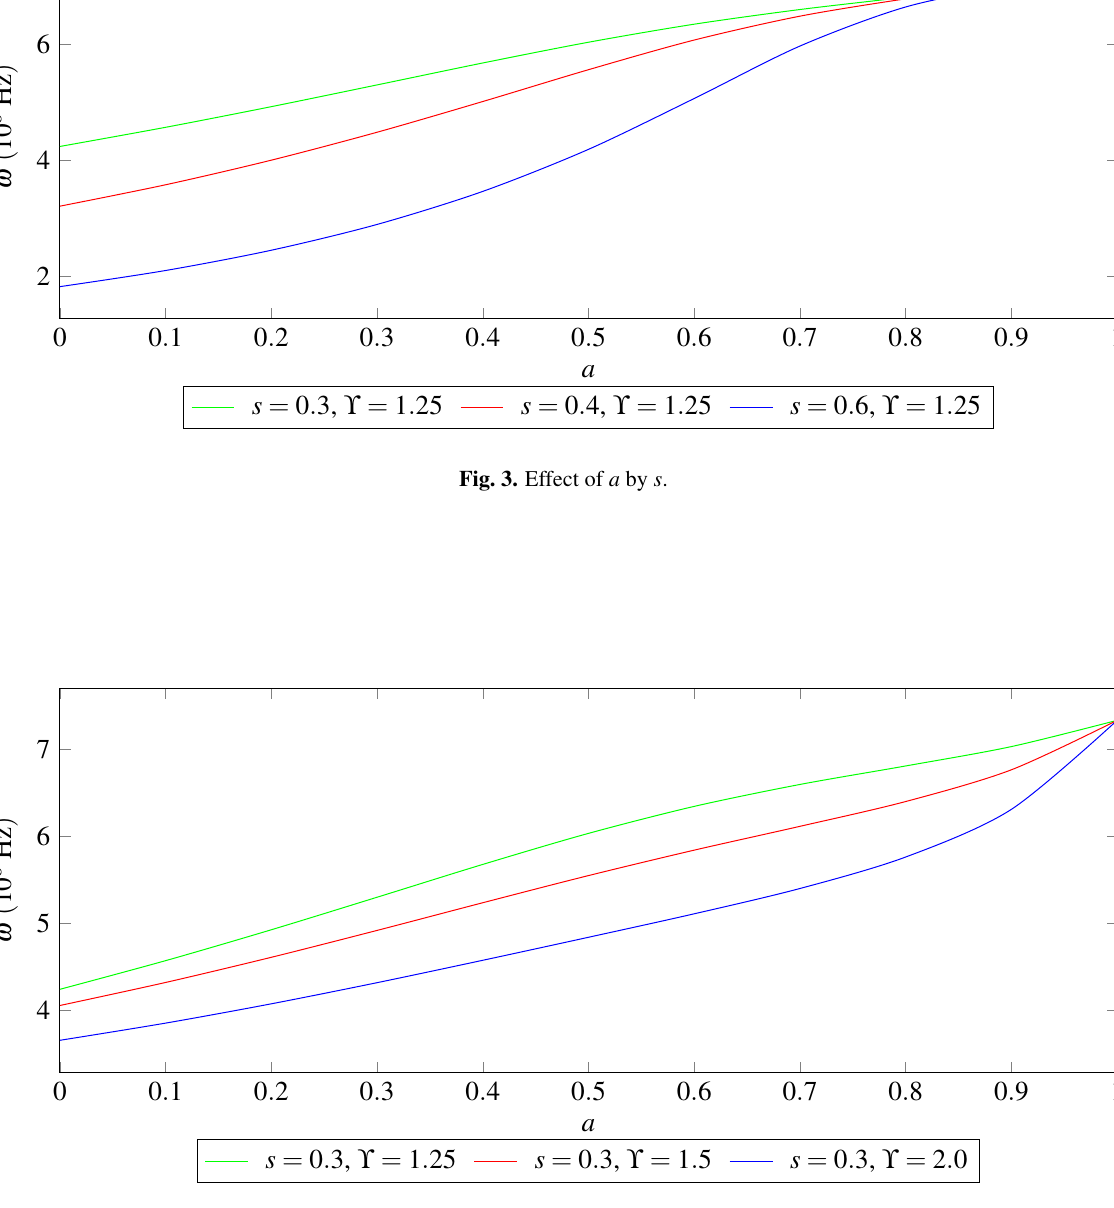
Fig. 4. Effect of a by ϒ